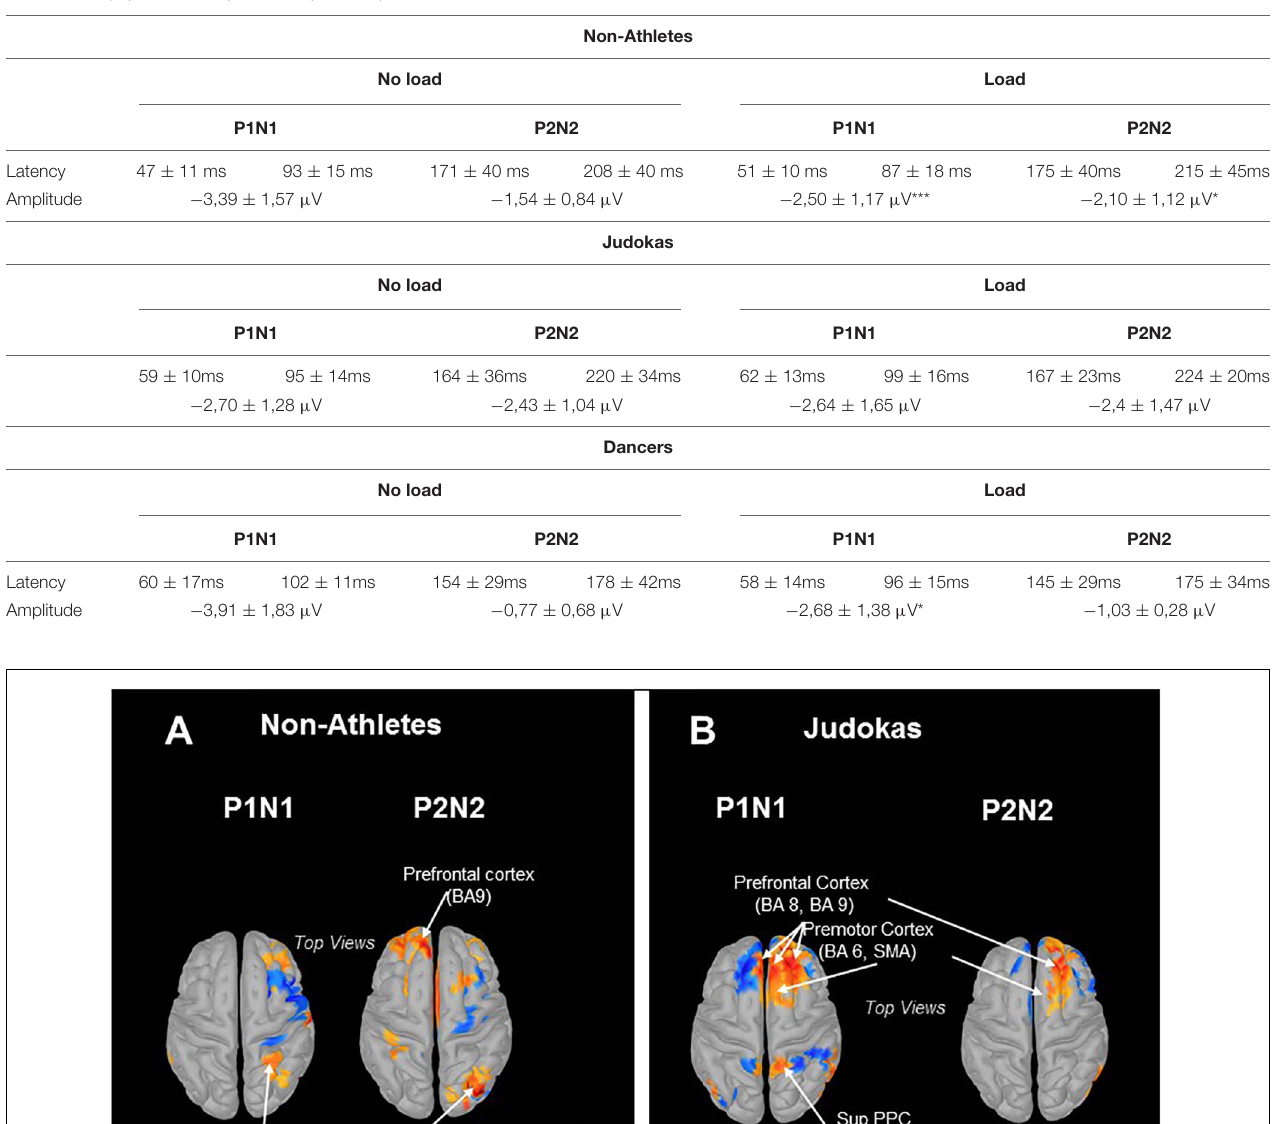
Frontiers in Human Neuroscience |